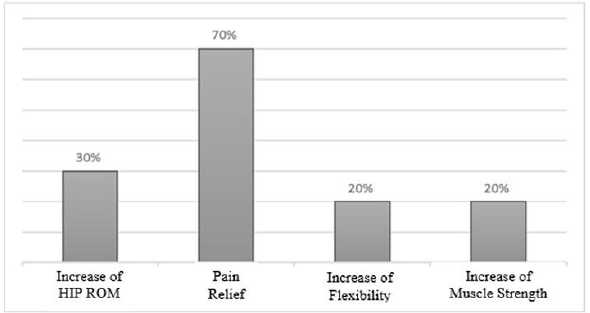
Figure 2: Main results observed with the neural mobilization